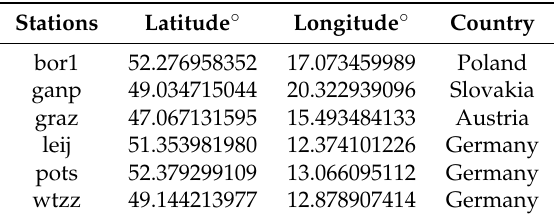
Table 1. Approximate location of six selected stations of IGS network and the countryt of their origin.